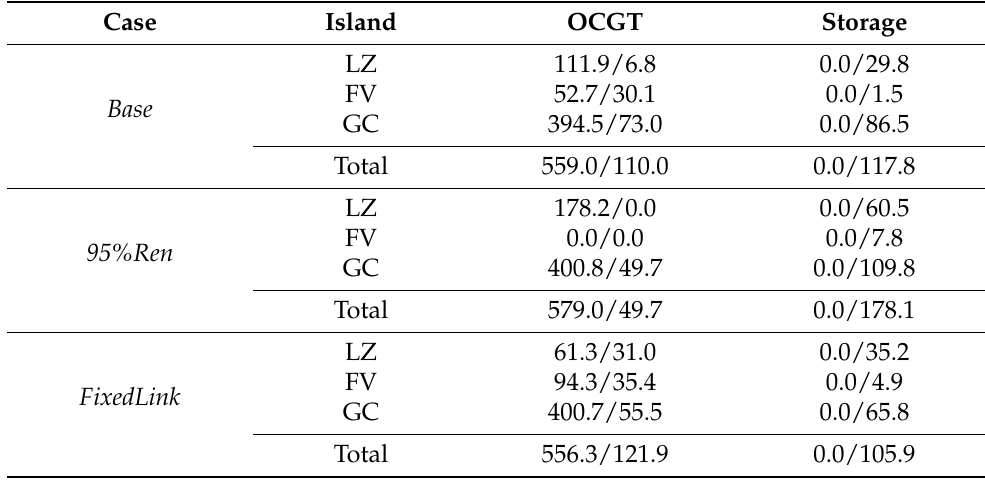
Figure 10. Energy produced and consumed in a scenario with high demand and high penetration of electric vehicles (scenario 7 described in Table 9). Table 16. Up/Down reserve capacity scheduled